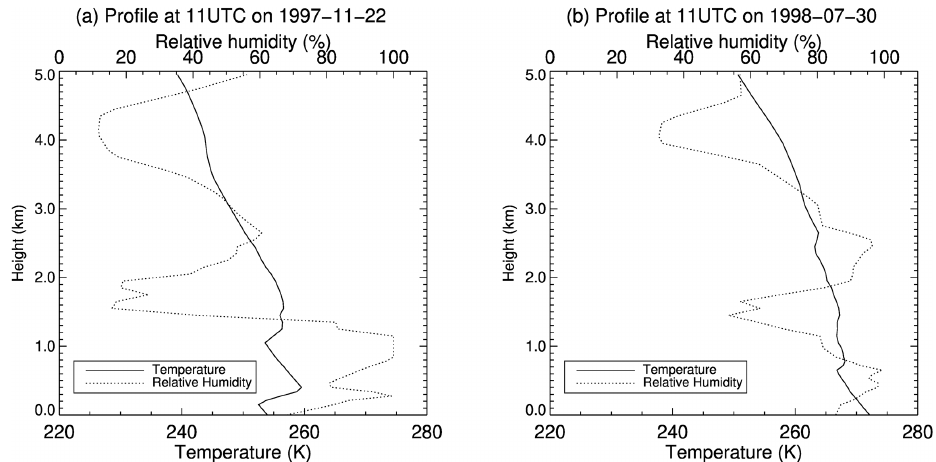
Figure 13. Temperature and relative humidity profiles on (a) 21 November 1997 and on (b) 30 July 1998 over the Arctic Ocean during the SHEBA